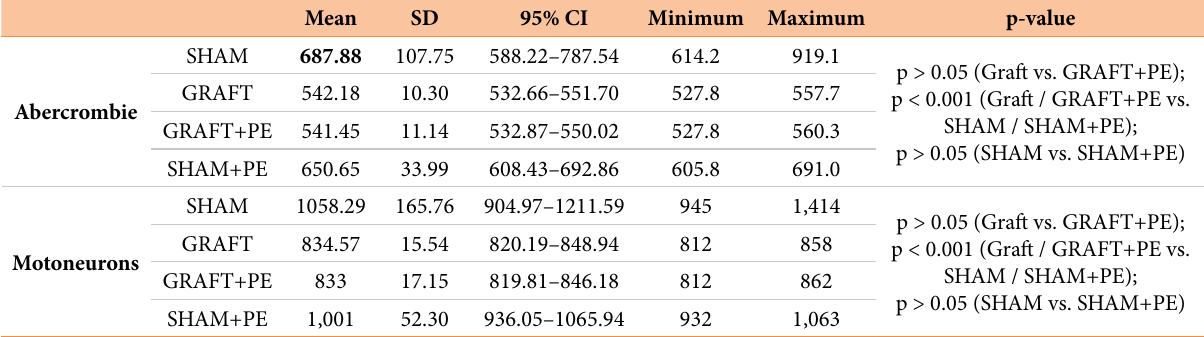
Table 3 - Motor neuron counts with and without Abercrombie’s correction across the four